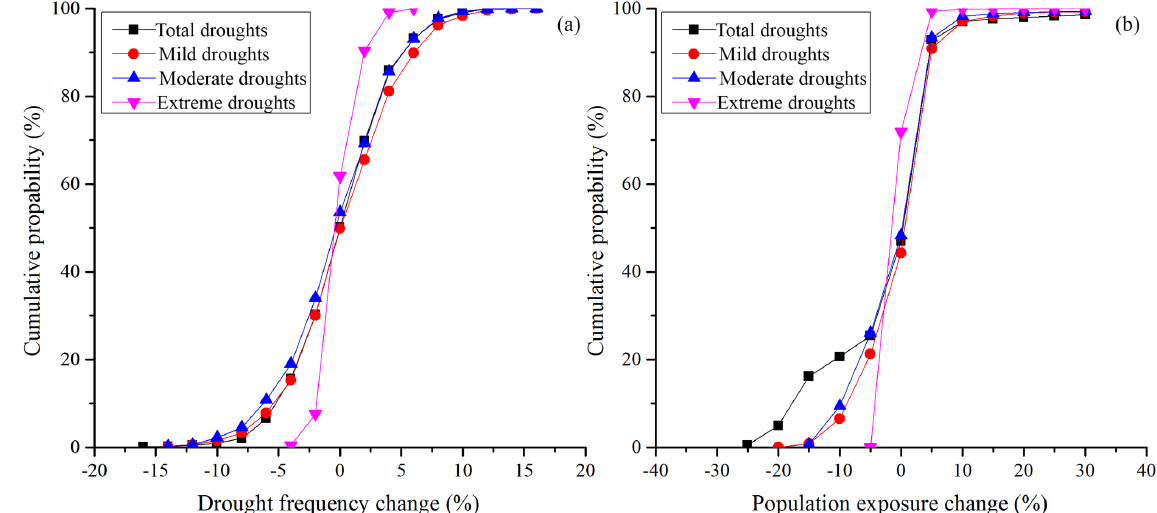
Figure 5. Cumulative probability projected change drought frequency (a) and population exposure (b) to mild, moderate, extreme, and total